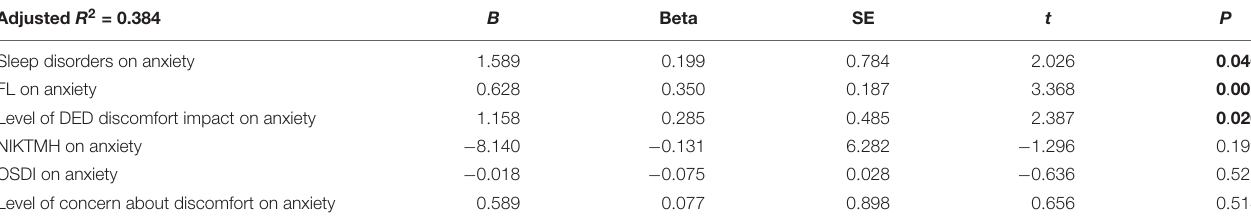
TABLE 10 | Multiple linear regression analysis of association between anxiety scores, demographic and dry eye parameters in patients aged 41–65. Adjusted R 2 = 0.384